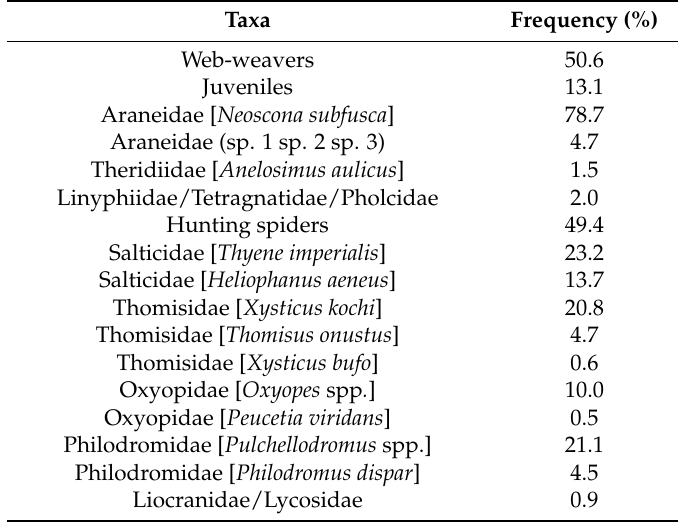
Table 2. Frequency (%) of spiders collected in 21 newly planted shrubs established in a highly disturbed horticultural system.